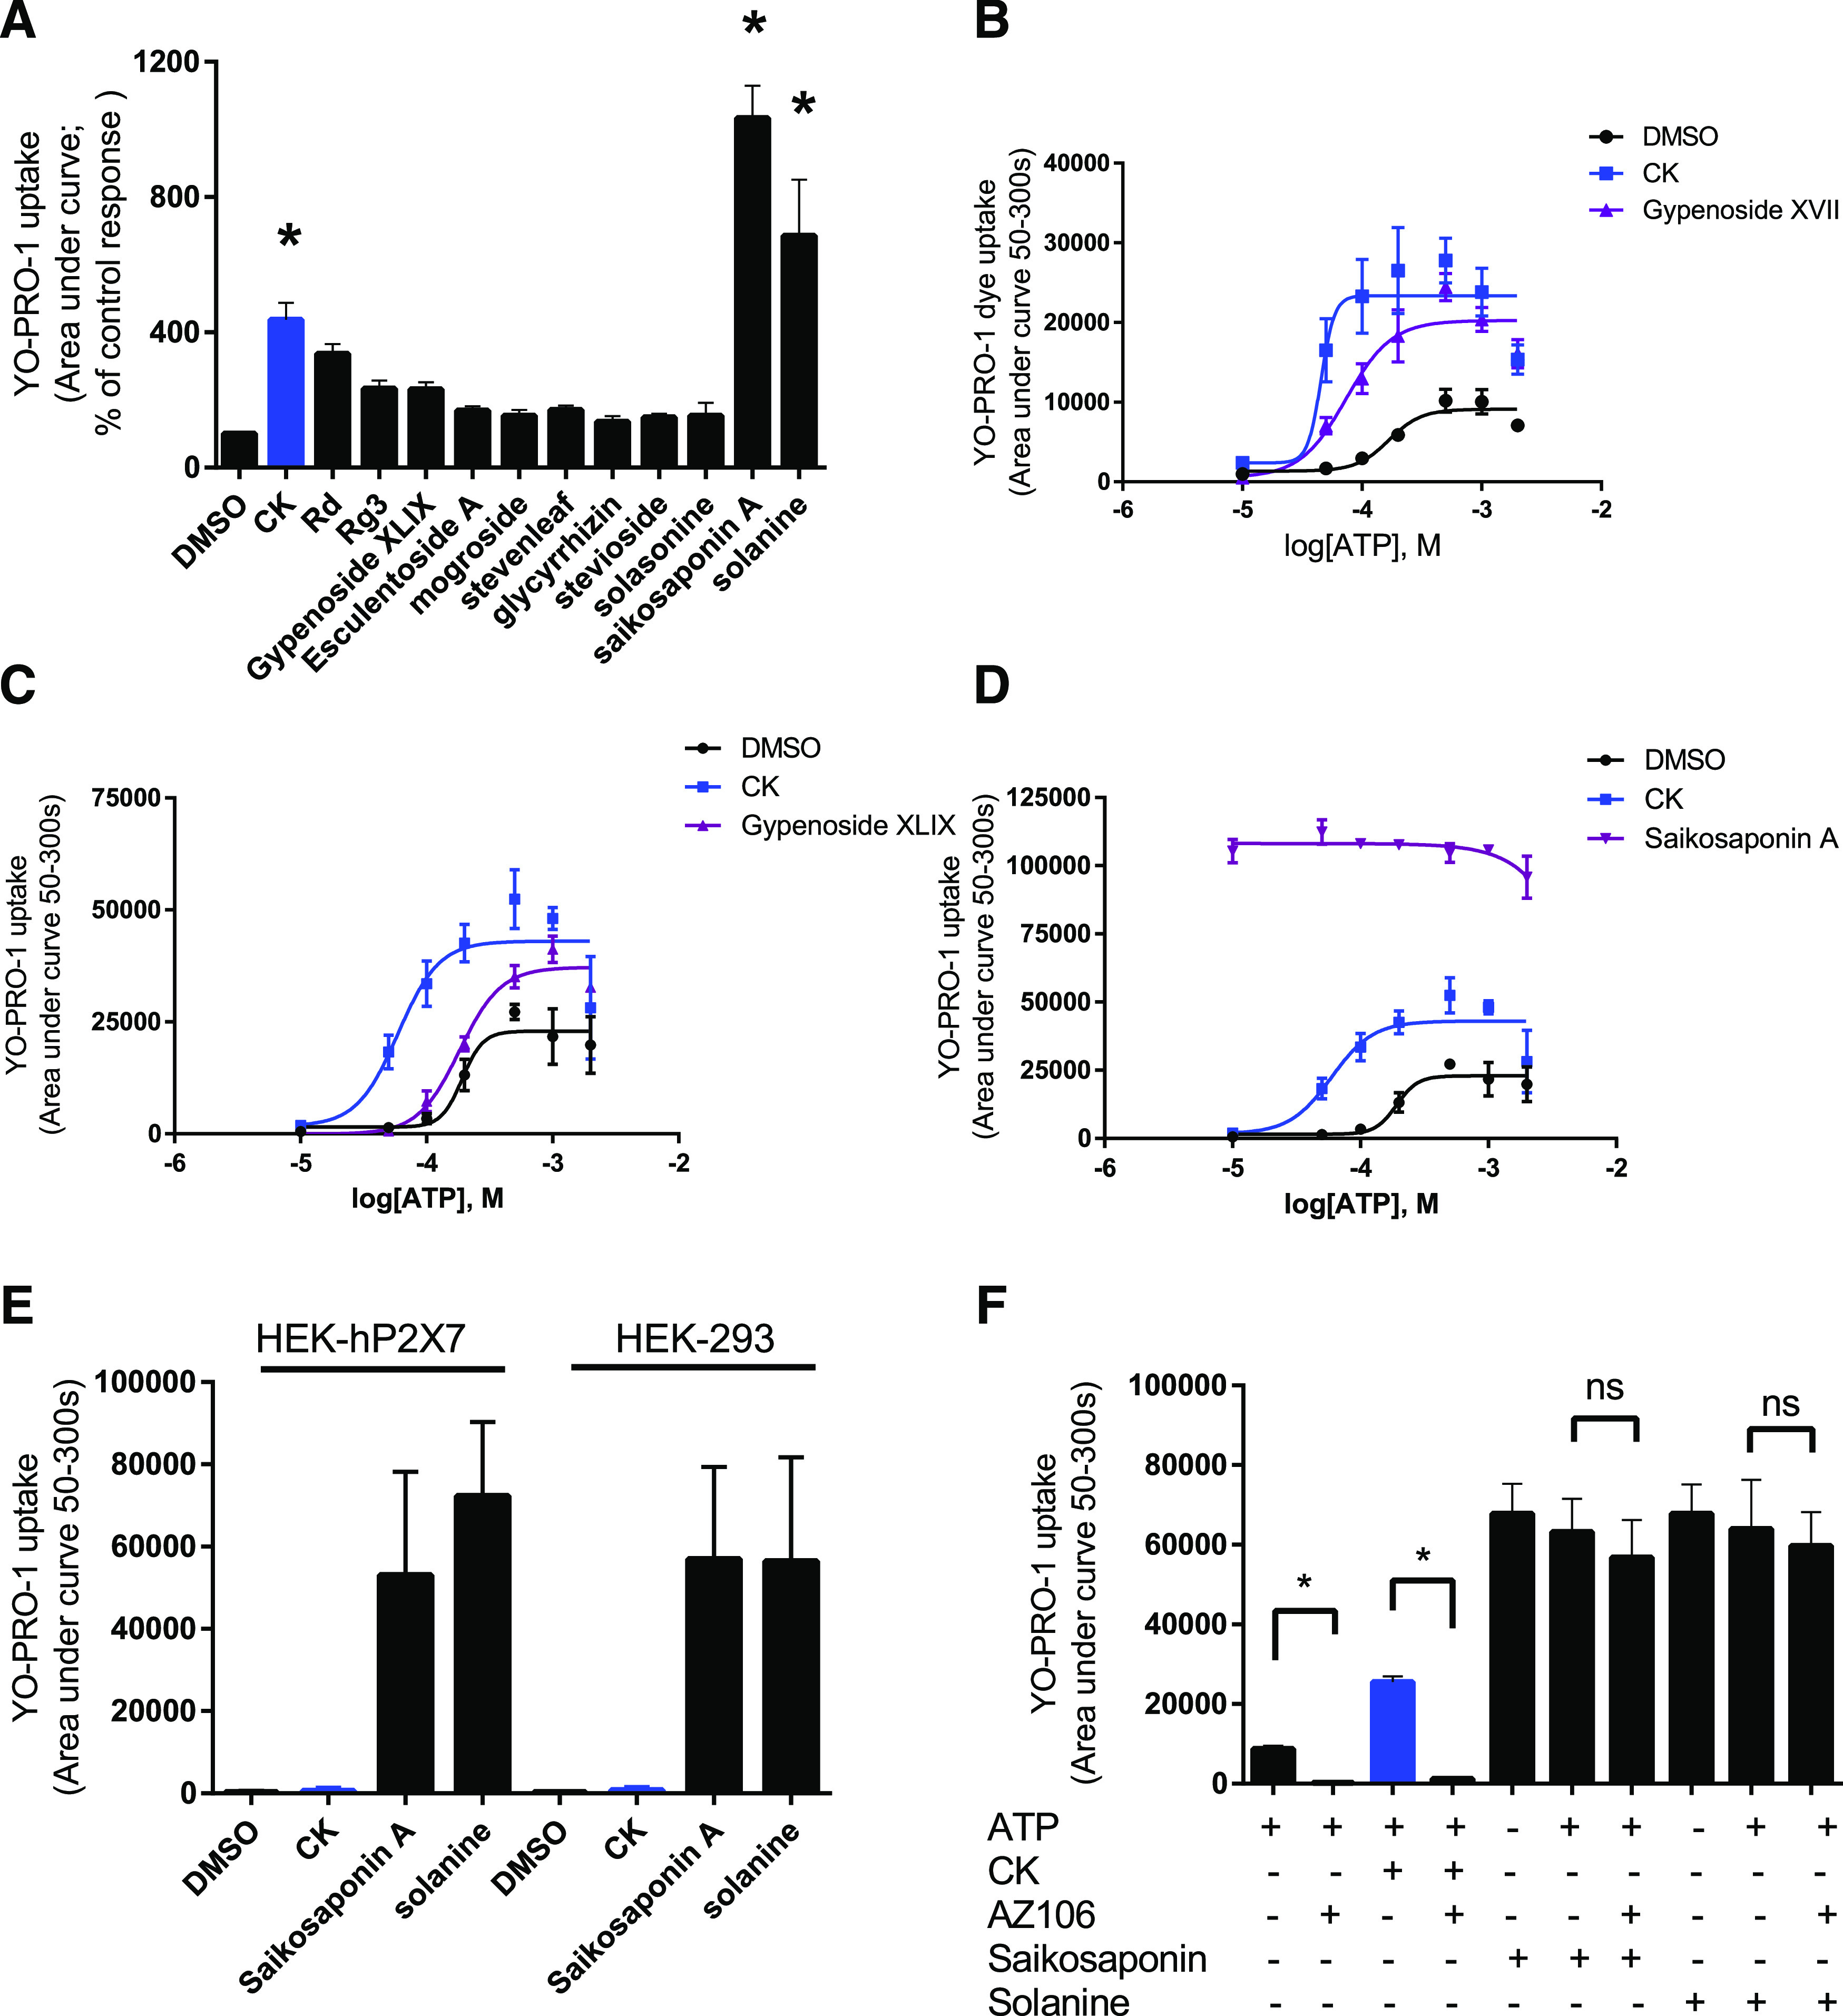
Screening glycosides containing disaccharide and trisaccharide moieties at P2X7. (A) Initial experiments used a fixed concentration of ATP (200 µM final) and glycoside (10 µM final) to screen selected glycosides at P2X7. Data are collated from two to four independent experiments. Ginsenoside-CK was used as the control PAM and is shown in blue. YO-PRO-1 uptake was measured as area under curve (50–300 seconds), and data are expressed as percentage of control, where the control is ATP + DMSO. One-way ANOVA with Dunnett’s multiple comparisons test was performed. *P < 0.05 compared with DMSO control. (B) Dose-response curve to ATP in the presence of vehicle (DMSO), ginsenoside-CK, or gypenoside XVII (10 µM). (C) Dose-response curve to ATP in the presence of vehicle (DMSO), ginsenoside-CK, or gypenoside XLIX (10 µM). (D) Dose-response curve to ATP in the presence of vehicle (DMSO), ginsenoside-CK, or saikosaponin A (10 µM). Data points are means ± S.D. The same curves from DMSO and ginsenoside-CK are shown in (B and D). (E) Summary of data from YO-PRO-1 uptake experiments in HEK-hP2X7 cells or parental nontransfected HEK-293 cells in response to drug alone (saikosaponin A or solanine). (F) Lack of effect of the P2X7-selective antagonist AZ10606120 (AZ106; 10 µM) on ATP-induced YO-PRO-1 uptake when solanine or saikosaponin were used. One-way ANOVA with Sidak’s multiple comparisons test was performed. *P < 0.05, ns denotes not significant.